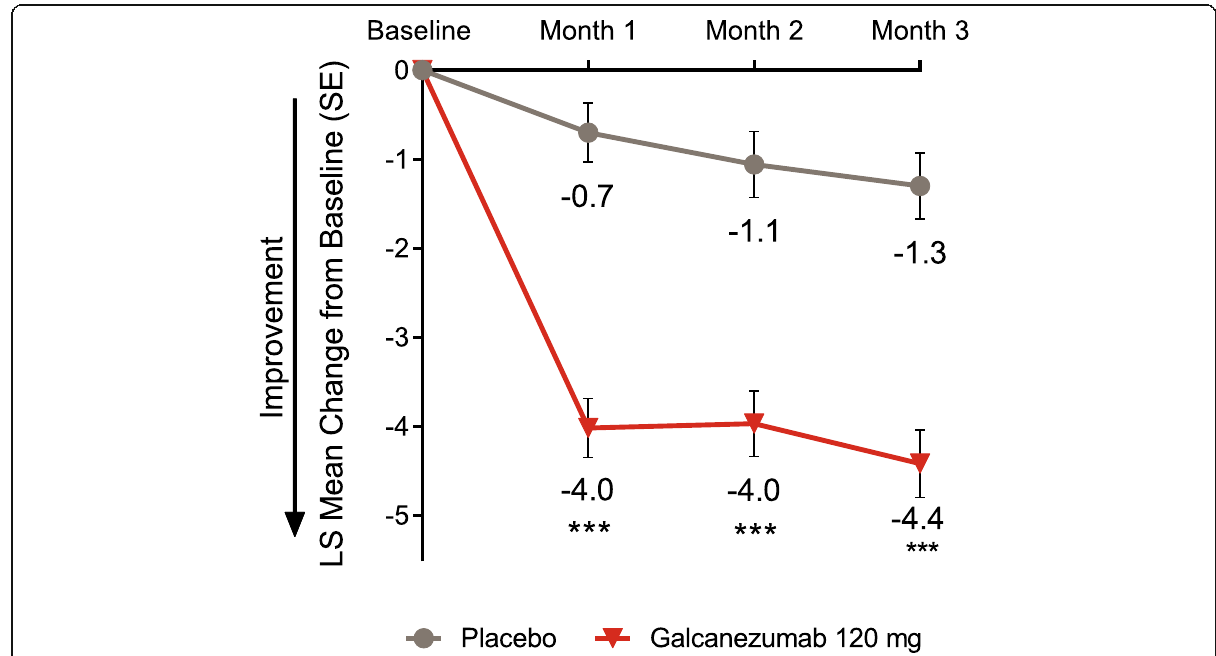
Fig. 1 LS mean change from baseline in number of monthly migraine headache days. *** p ≤ 0.0001 vs placebo. LS least-squares. SE